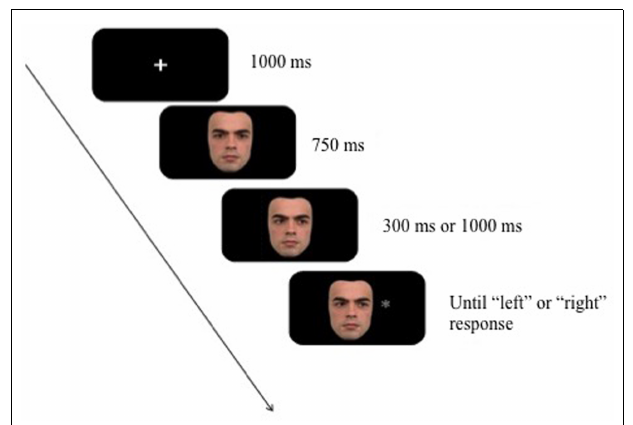
FIGURE 1 | Example trial sequence from Experiment 1 (not drawn to sale).